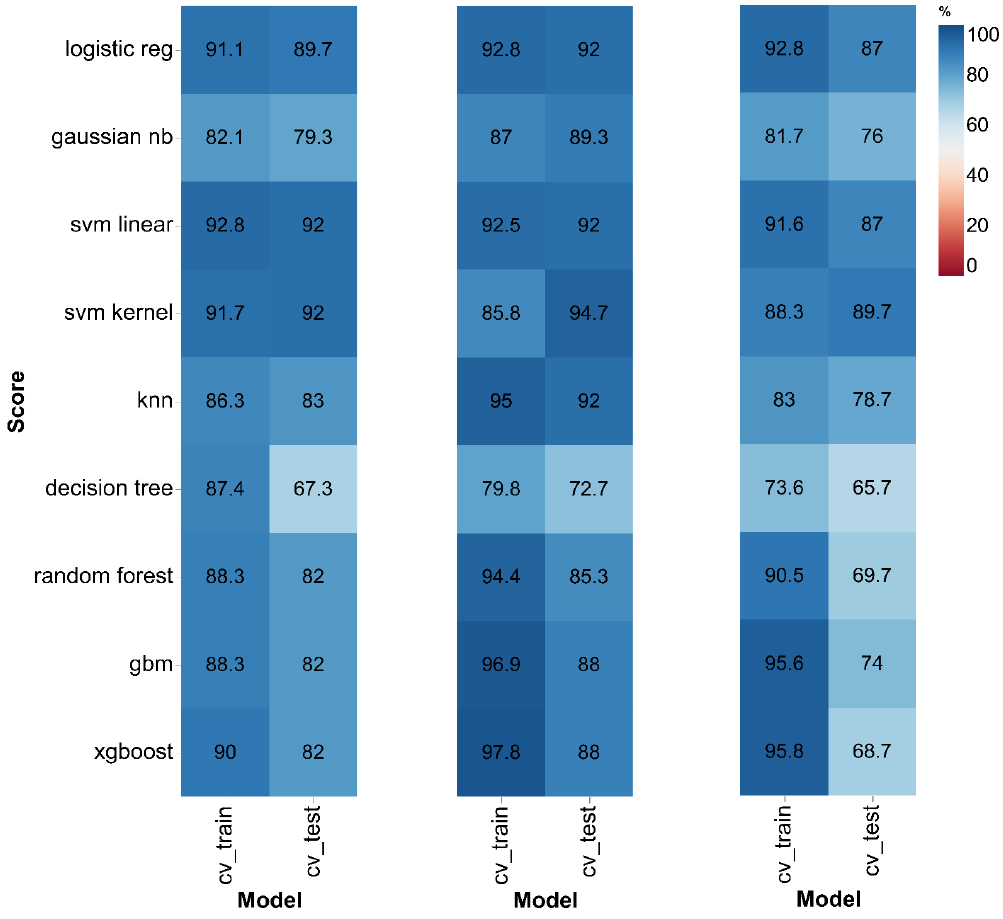
Figure 2. AUC values of various machine learning algorithms evaluated for the prediction of LRRK2 PD as compared LRRK2 controls, sPD as compared to sPD controls, and LRRK2 PD as compared to sPD on both test and training sets,